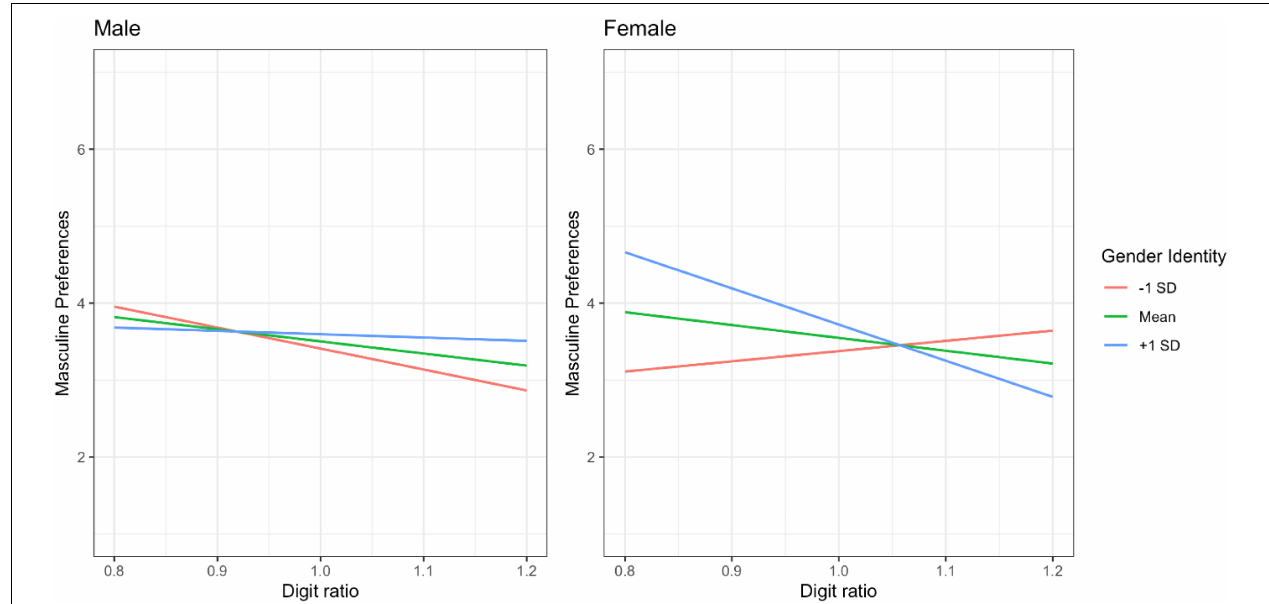
FIGURE 2 | Male (left) and female (right) participants’ preferences for more masculine consumption options, depending on their digit ratio, which ranged from 0.80 to 1.20, and gender identity ( M ± 1 SD ), with M – 1 SD indicative of a feminine gender identity and M + 1 SD indicative of a masculine gender identity.